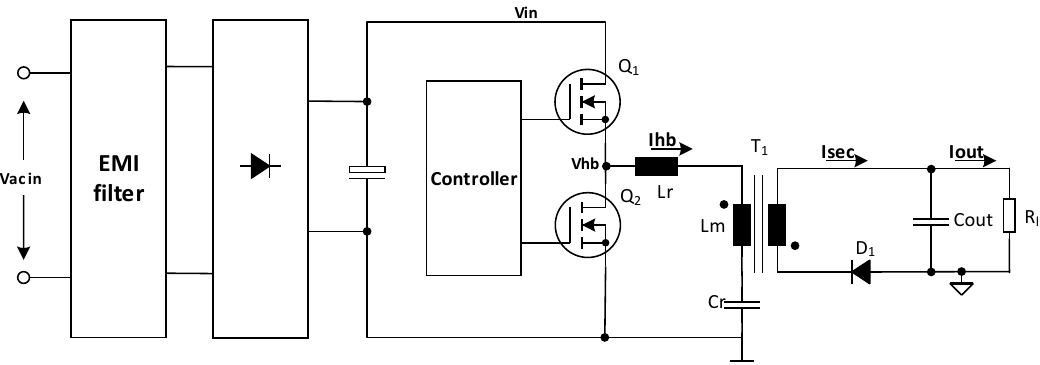
Figure 1. Simplified adaptor schematic of an asymmetric pulse width modulation (PWM) half-bridge (HB) flyback.